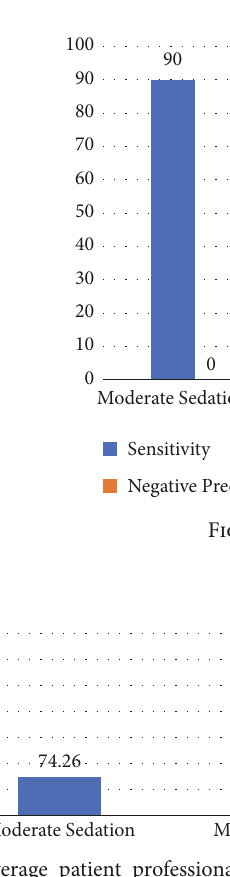
Figure 3: Average patient professional sedation charges in US